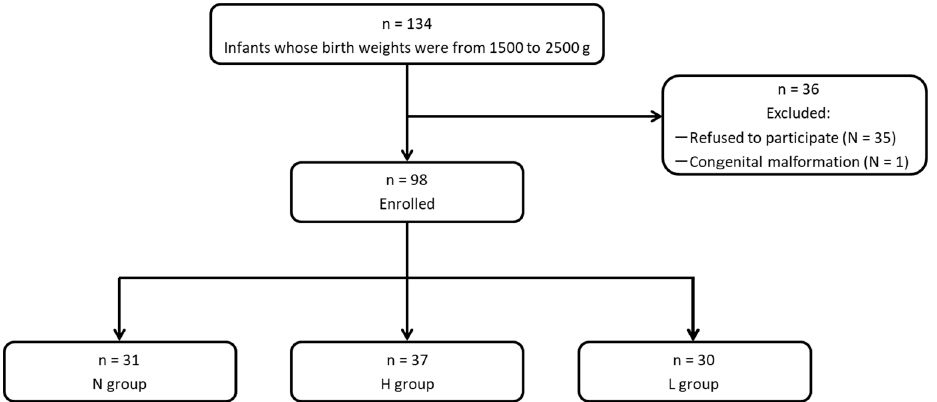
Figure 1. Classification of subjects. N group, non-intervention control; H group, non-live OLB6378; L group, live OLB6378.